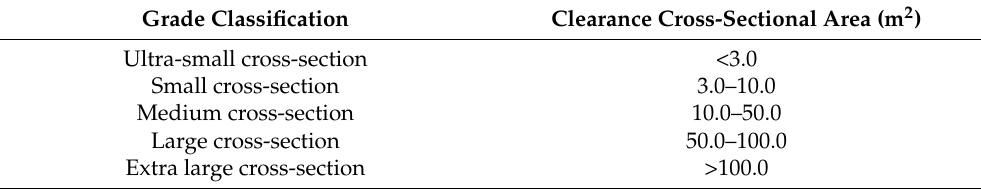
Figure 2. Tunnel excavation section size drawing. Table 1. Judgment criteria of the International Tunnelling Association for cross ‐ sections.